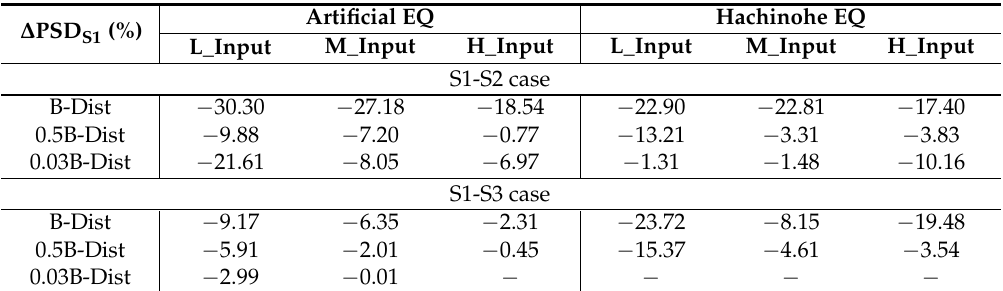
Table 4. Percentage change of total power spectra density ( ∆ PSD) of S1 structure for a series of tests with S2 and S3 structures placed